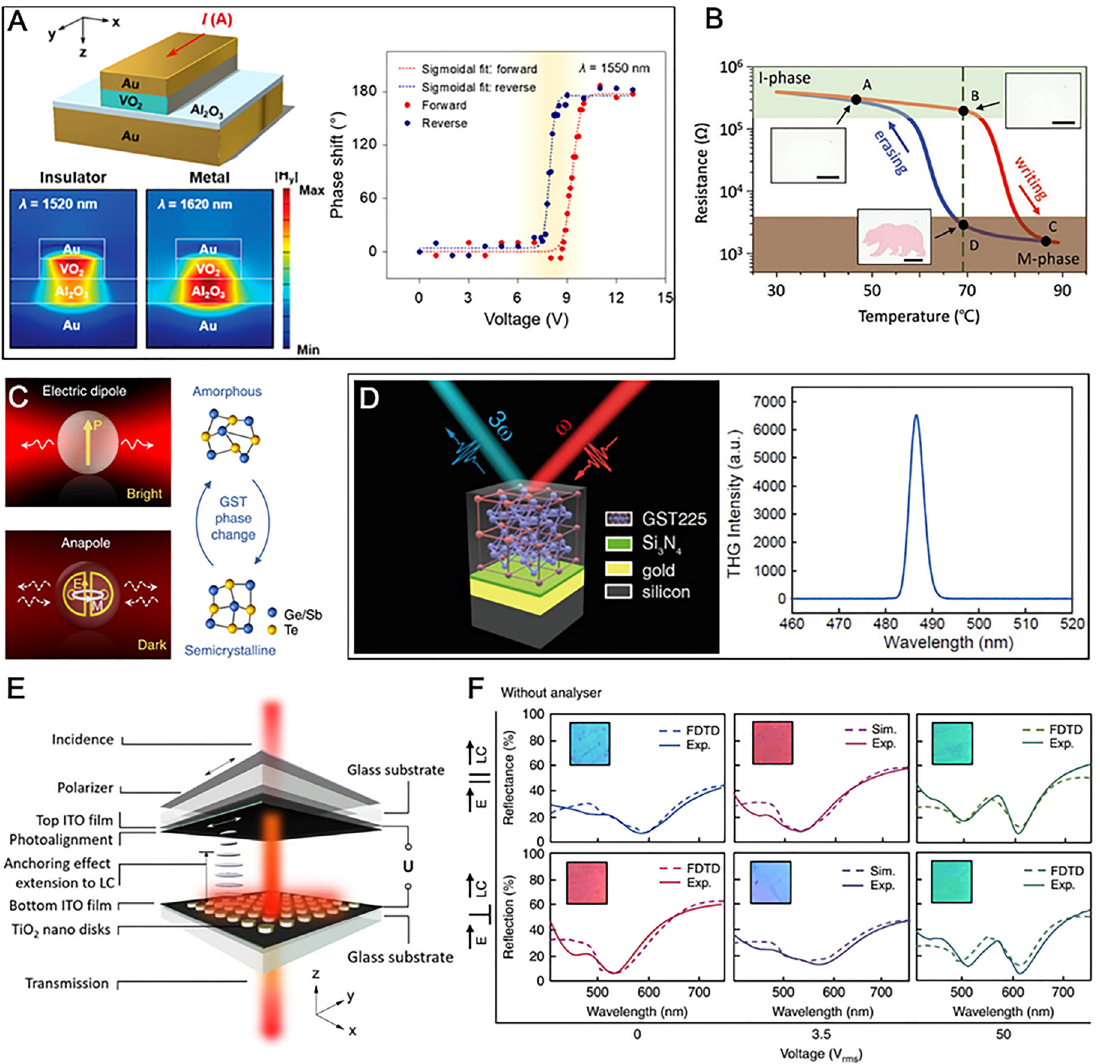
Figure 1: Tunable metasurfaces based on phase transitions. (A) Schematic of an electrically tunable VO 2 metasurface with simulated magnetic fi eld magnitude around the metasurface and the curve of phase shift as the function of the applied voltage [41]. (B) The writing and erasing process on the metacanvas applying the temperature-dependent resistanceofaVO 2 fi lm[45].(C)ConceptualdiagramofananapoleexcitationanelectricdipoleresonanceintheGSTsphere[60].(D)Schematicofa planar air/GST/Au multilayer Fabry – Perot cavity with corresponding spectra of THG at λ = 1450 nm [66]. (E) Schematic of the transmission-type LC-based TiO 2 dielectric metasurface device [73]. (F) The relationship between the measured/simulated re fl ection spectra and the applied fi eld/ input polarization in the modulation of LC-based structural color [75]. GST, GeSbTe alloys; THG, third-order harmonic generation; LC, liquid